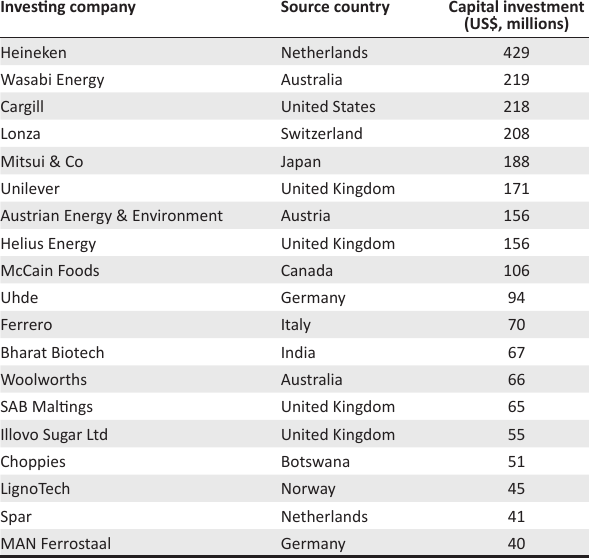
TABLE 3: Major agricultural foreign direct investment inflows to South Africa by company, 2003–2014. Investing company